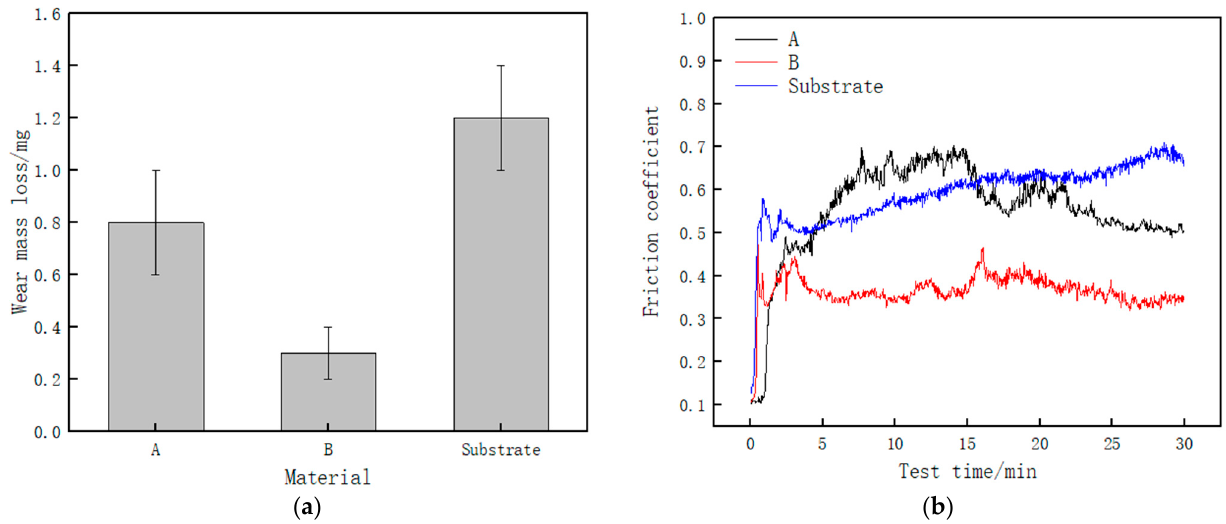
Figure 10. Curves of wear and friction coefficient of cladding layer and substrate. ( a ) Wear of cladding layer and substrate; ( b ) curve of the friction coefficient between cladding layer and substrate.